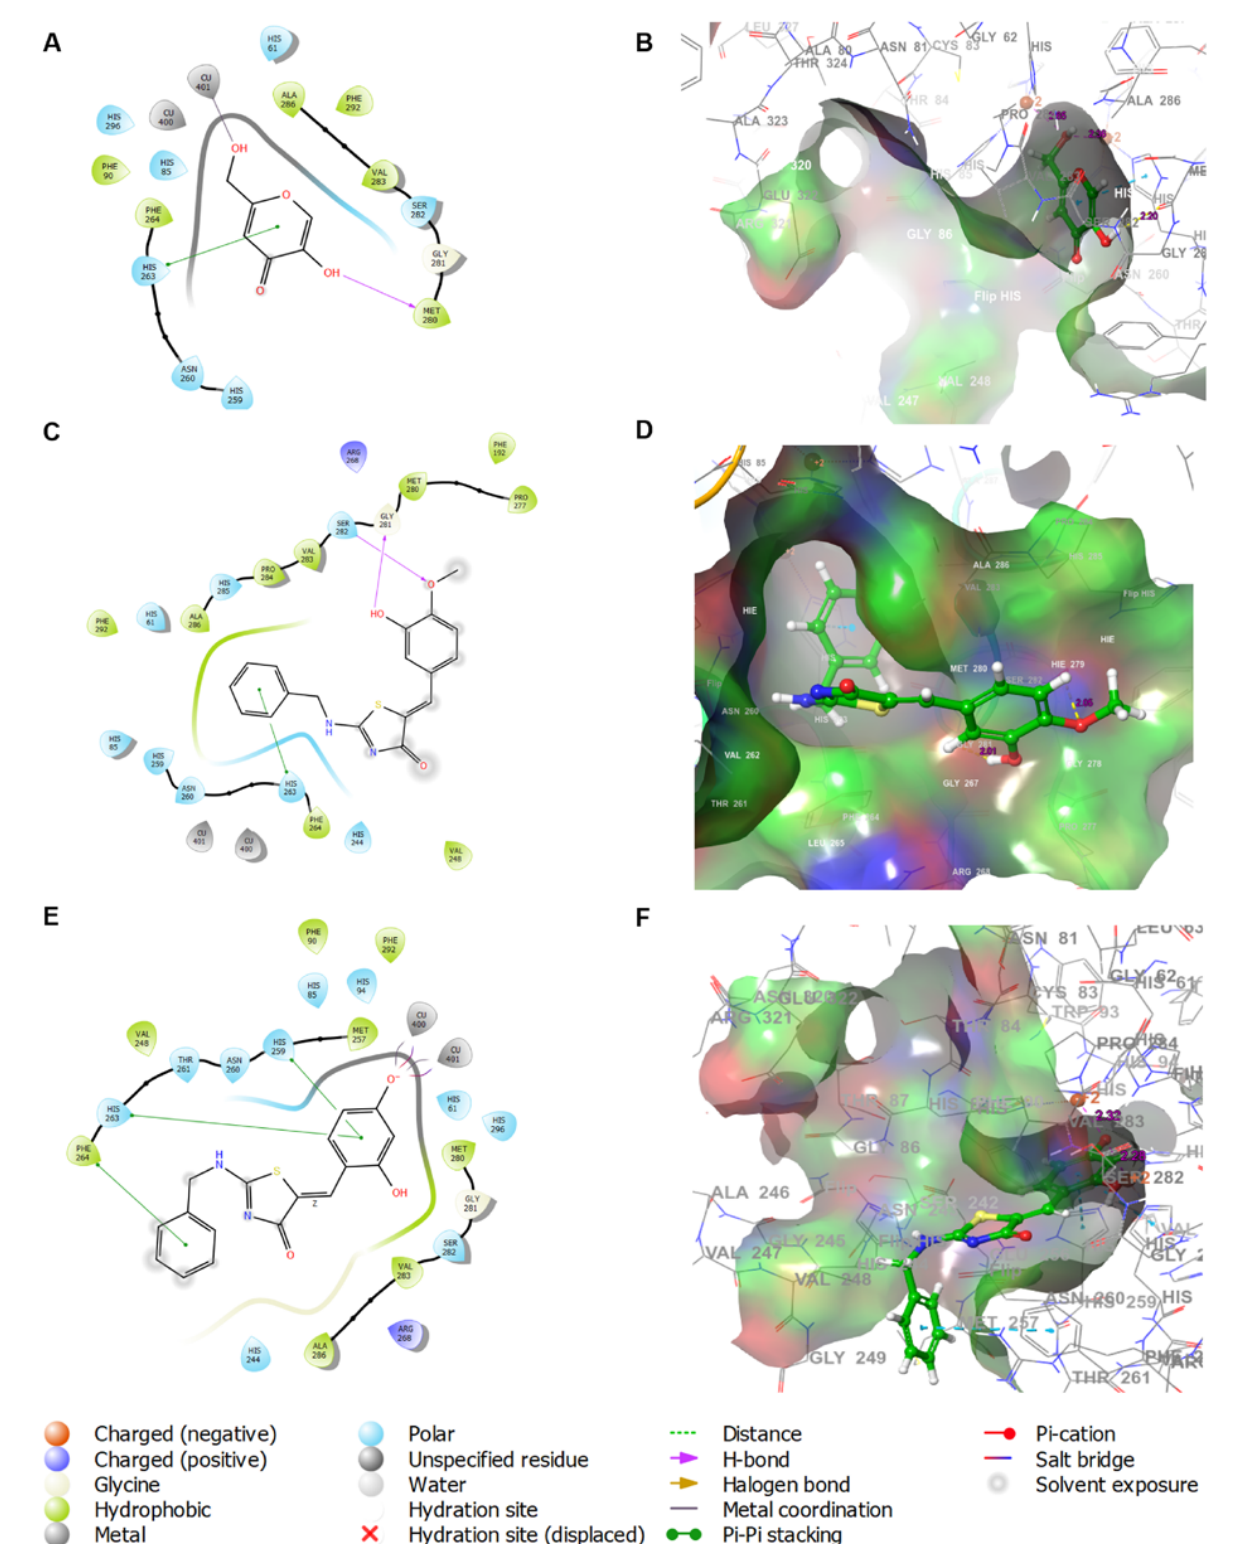
Figure 4. In silico docking simulation of kojic acid and derivatives 7 and 8 with mushroom tyrosinase using the Schrödinger Suite. Binding interactions between the amino acid residues of mushroom tyrosinase and the ligands, kojic acid ( A , B ), 7 ( C , D ), and 8 ( E , F ), are displayed in 2D and 3D.